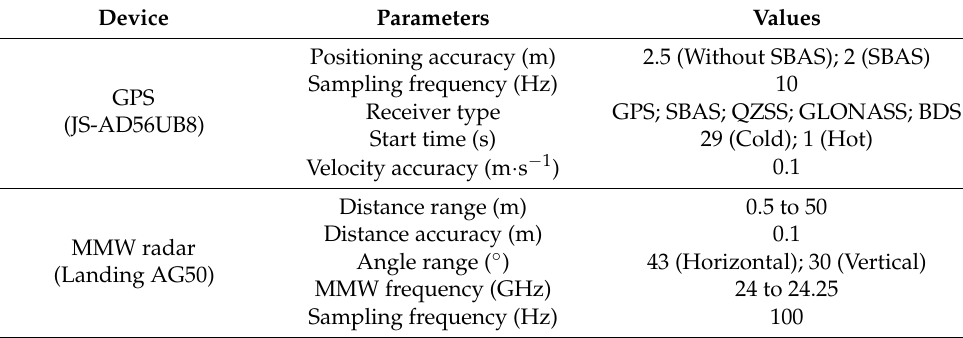
Table 3. Parameters of onboard GPS and MMW